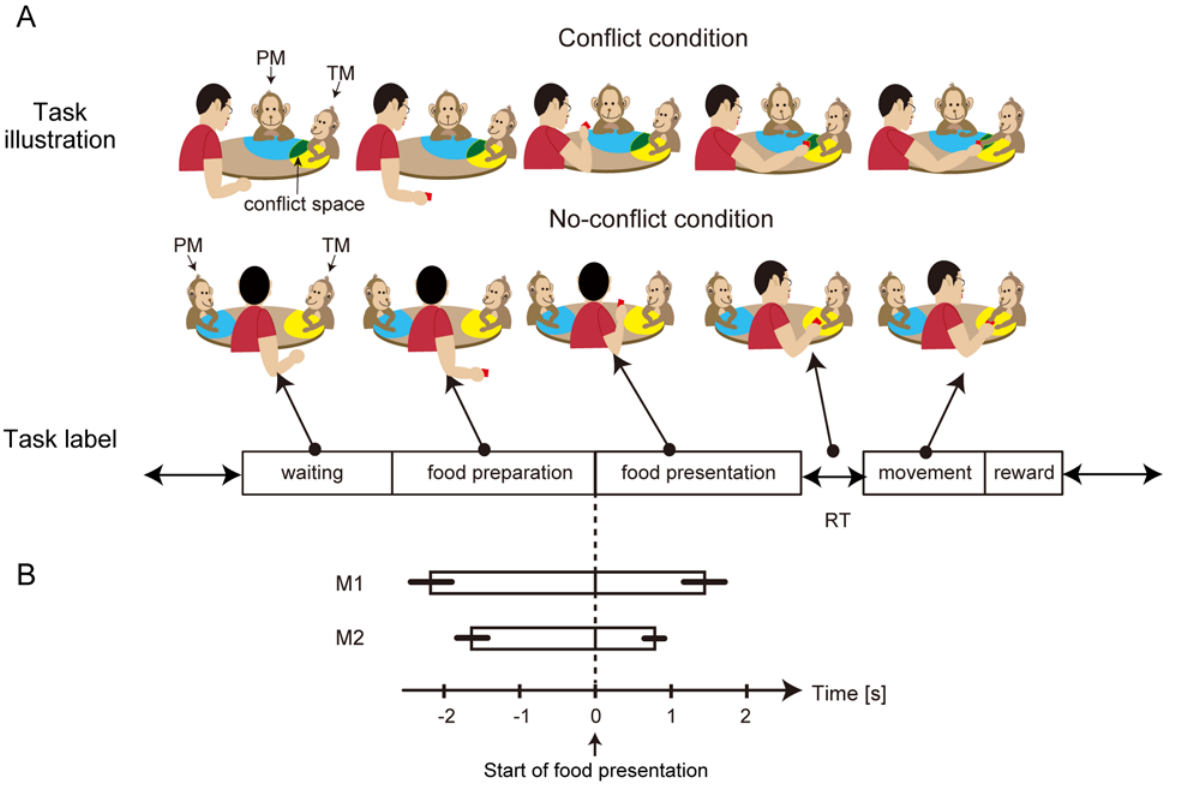
Fig 1. Schematic explanation of the social food-grab task. A. Task illustration: Schematic sequence of the food-grab task in the conflict and no-conflict conditions. The task had five periods: waiting, food preparation, food presentation, movement, and reward. TM, target monkey; PM, paired monkey. The spaces around the monkeys that were reachable only by the TM and PM are shown in yellow and blue, respectively. Green represents the conflict space, which was shared by the TM and PM. Task label: The labels of the five periods are shown under the Task illustration. RT, reaction time between the end of the food-presentation period and the onset of the movement period. B. Duration of the average food-preparation and food-presentation periods for M1 and M2 for their respective trials is shown as bars before and after the onset of the food-presentation period. The error bars indicate the SDs for the